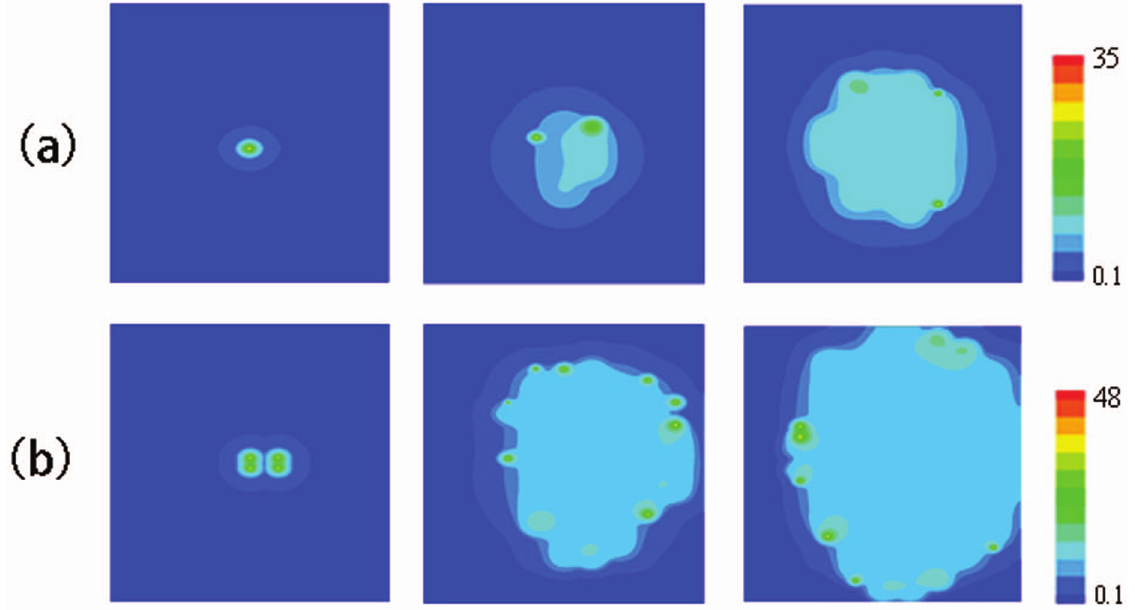
Figure 5. Illustration of. Ca 2 z waves induced by physiological Ca 2 z sparks. (a)Snapshots of Ca 2 z waves initiating from a 10ms opening of the CRU at the point (10,9.6), snapshots are taken at 10, 330 and 490ms. The value of parameters are b ~ 2 : 25 , I CRU ~ 2p A and l x ~ 2 : 0 m m . (b)Snapshots of Ca 2 z waves initiating from 10ms opening of the CRUs at the point (10,9.6), (12,9.6), (10,10.4) and(12,10.4), snapshots are taken at 10, 330 and 490ms. The value of parameters are b ~ 2 : 25 , I CRU ~ 2p A and l x ~ 2 : 0 m m